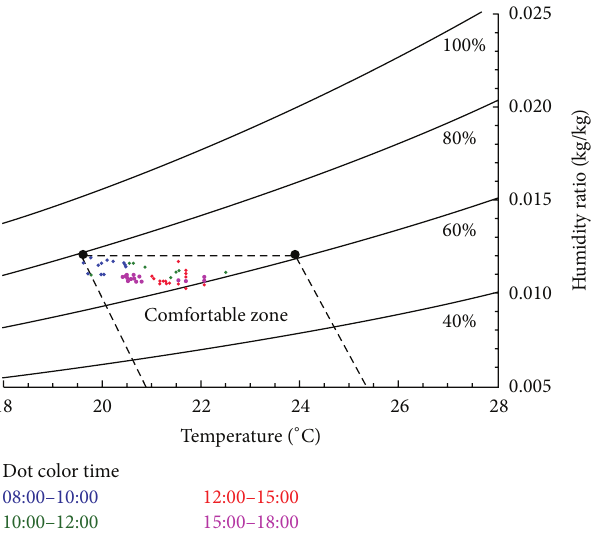
Figure10:Theelectricityconsumptionofexistingandimprovedair- conditioning systems.